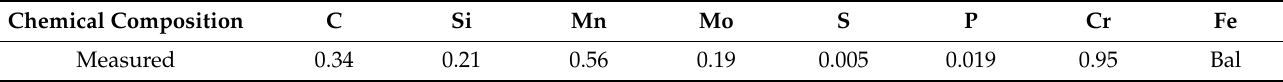
Figure 1. Detailed experimental process of tests: ( a ) ultrasonic casting of 35CrMo steel, ( b ) sampling diagram and ( c ) hot compression test. Table 1. Composition of GB 35CrMo steel (wt